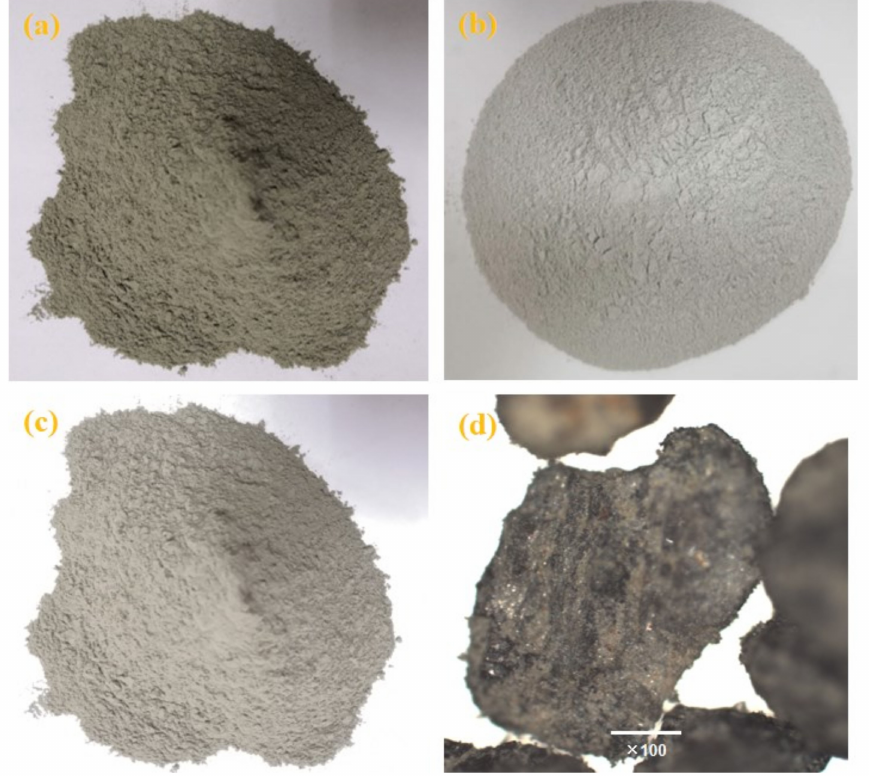
Figure 1. The physical appearance of ( a ) cement, ( b ) silica fume (SF), and ( c ) iron tailing powder (ITP), and ( d ) morphology of the ITP.